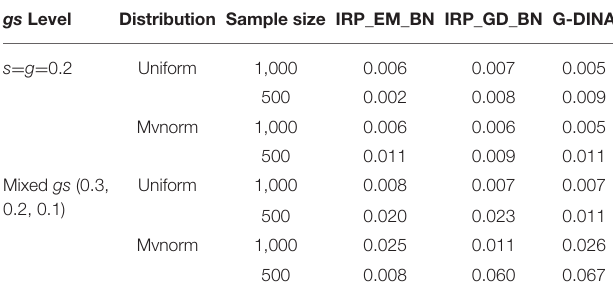
TABLE 7 | The standard error of AACR by BNs and G-DINA from the data generated by G-DINA. gs